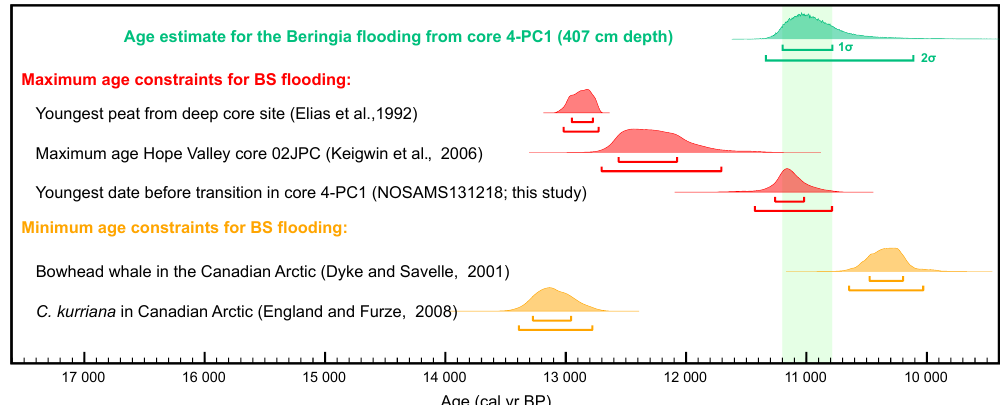
Figure 7. Published age estimates of the Bering Strait (BS) flooding compared with the age estimate from this work (green). The age estimates are divided into maximum (red) and minimum (yellow) age constraints. All ages and calibrations are listed in Table 1 and are shown here as calendar years BP (see text regarding the applied calibration of 14 C